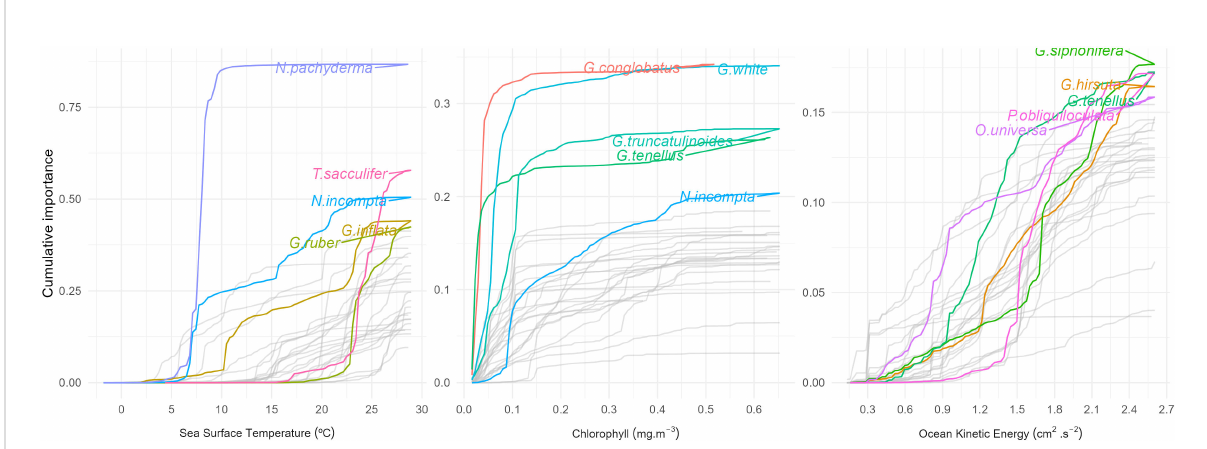
FIGURE 5 Cumulative change in abundance of individual foraminifera species, marking the values of the variable (Sea Surface Temperature (SST, °C), Chlorophyll- a (CHL, mg m -3 ), Eddy Kinetic Energy (EKE, cm 2 s -2 )), where changes occur, i.e., the values at which species change the most for each gradient. Legend is shown only for the topmost important fi ve species in each gradient.